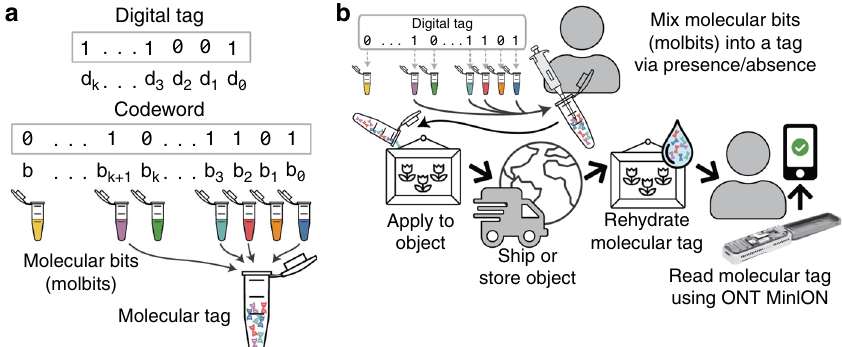
Fig. 1 Creating a molecular tag using the Porcupine molecular tagging system. a Porcupine ’ s encoding scheme. A digital tag is converted into a codeword to add additional bits for error correction. Each codeword bit is assigned to a unique molbit, where 1s and 0s are represented by the presence or absence of individual molbits in the molecular tag mixture. b A user fi rst de fi nes a digital tag as a binary 96-bit number, and pipettes 1-bits into the molecular tag. The tag is applied to an object, which is then shipped or stored. To read the tag, it is rehydrated and loaded directly onto Oxford Nanopore Technologies ’ MinION device. Software then decodes the molecular tag without knowledge of the original digital tag.